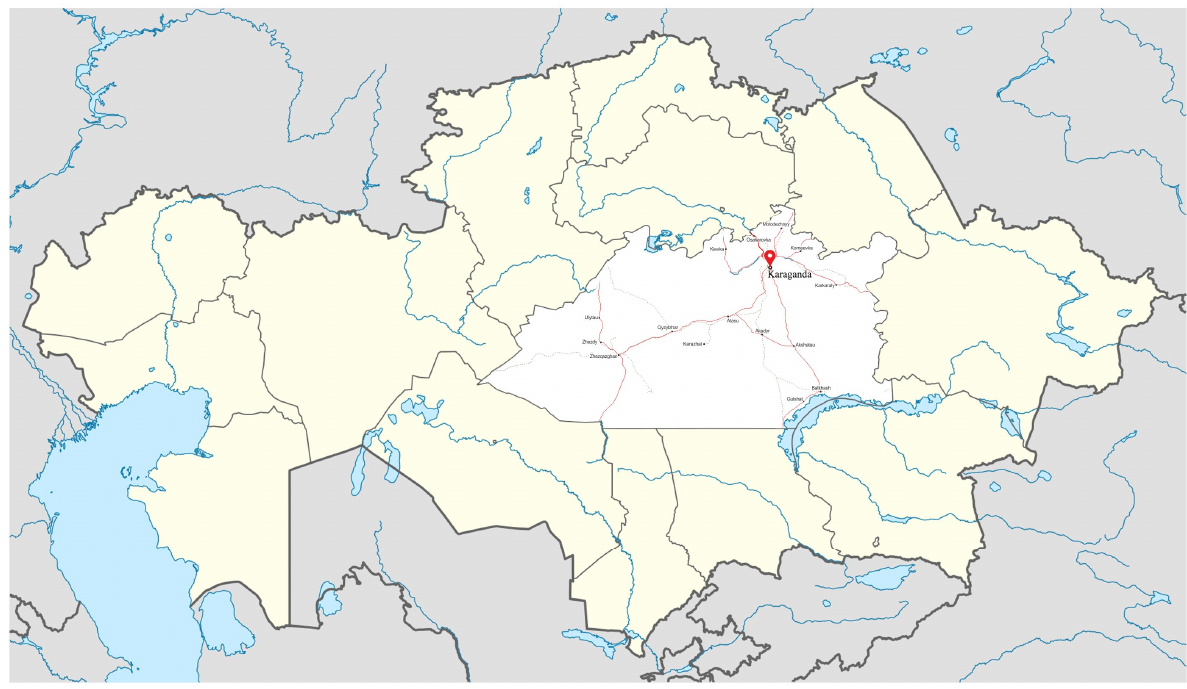
Figure 1. The location and borders of the Karaganda region and Karaganda city (selected area) on a map of the Republic of Kazakhstan. The figure was modified from Google maps (https://goo.gl/maps/1wGbBVcHgDUv646UA) accessed on 1 January 2022.